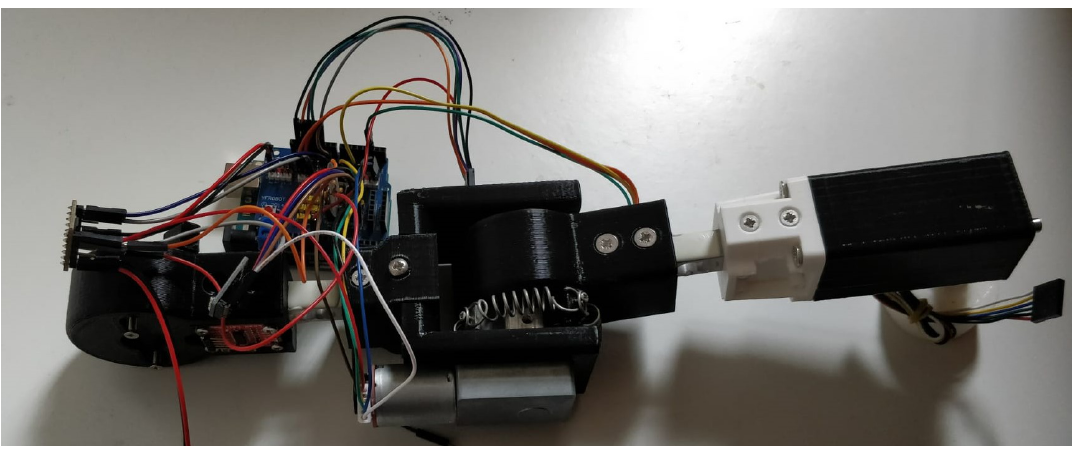
Figure 12. Real joint.